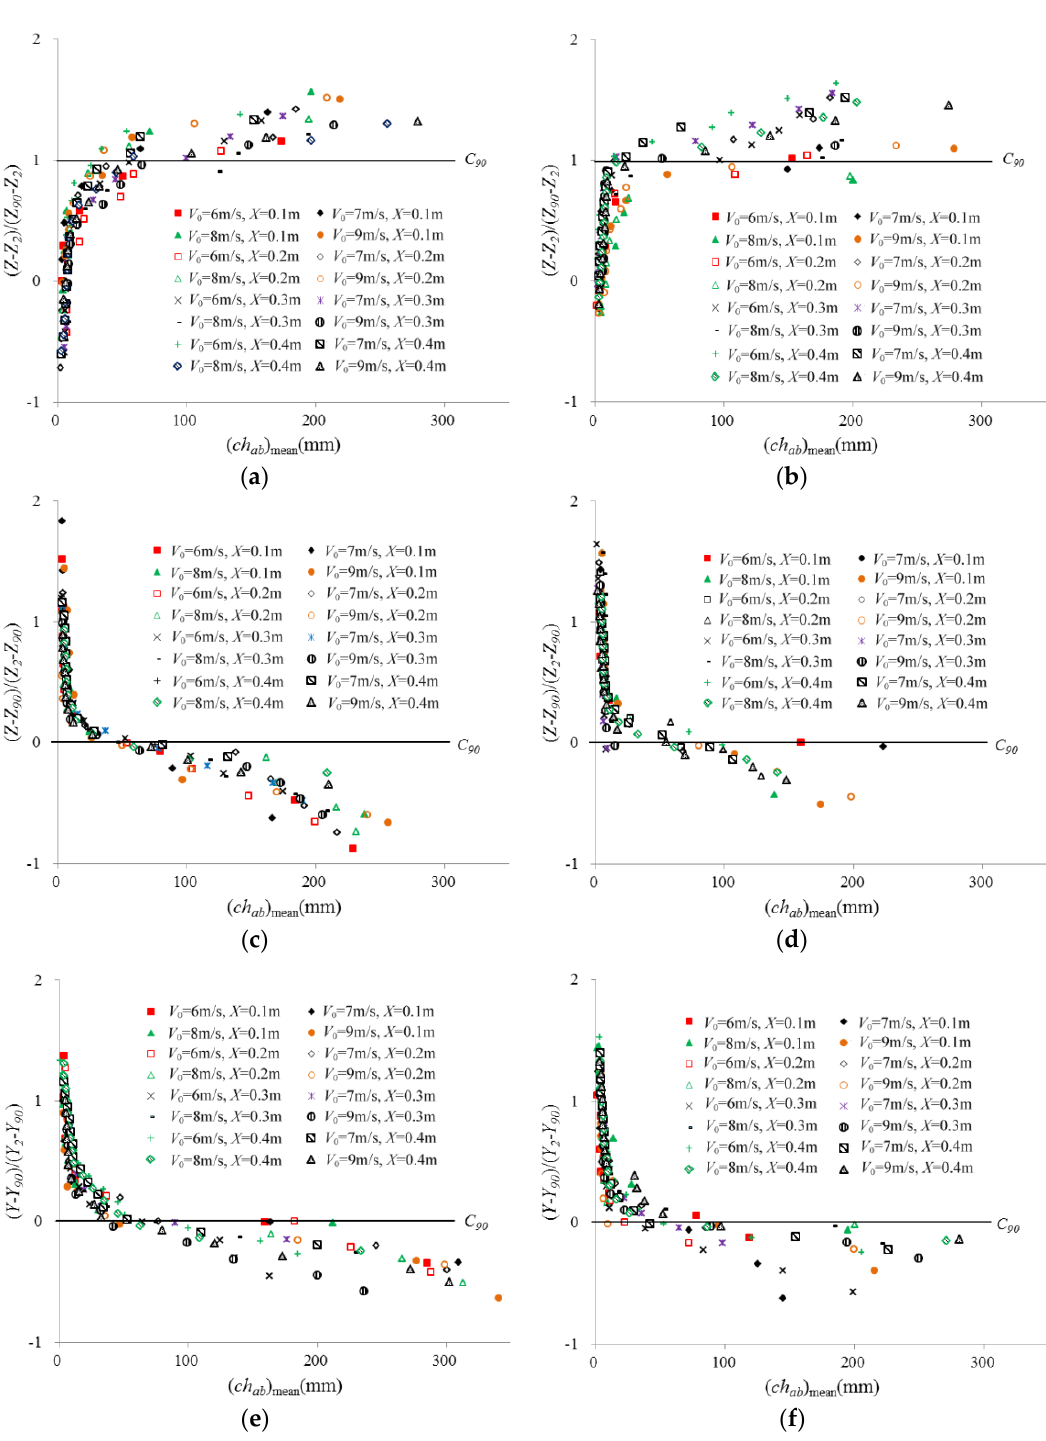
Figure 11. Air bubble chord length distributions. Upper nappe ( a ) ( h , b ) = (4.5 cm, 4.5 cm), θ = 0%. ( b ) ( h , b ) = (2.5 cm, 2.5 cm), θ = 10%; lower nappe ( c ) ( h , b ) = (4.5 cm, 4.5 cm), θ = 0%. ( d ) ( h , b ) = (2.5 cm, 2.5 cm), θ = 10%; side nappe ( e ) ( h , b ) = (4.5 cm, 4.5 cm), θ = 0%. ( f ) ( h , b ) = (2.5 cm, 2.5 cm), θ = 10%.